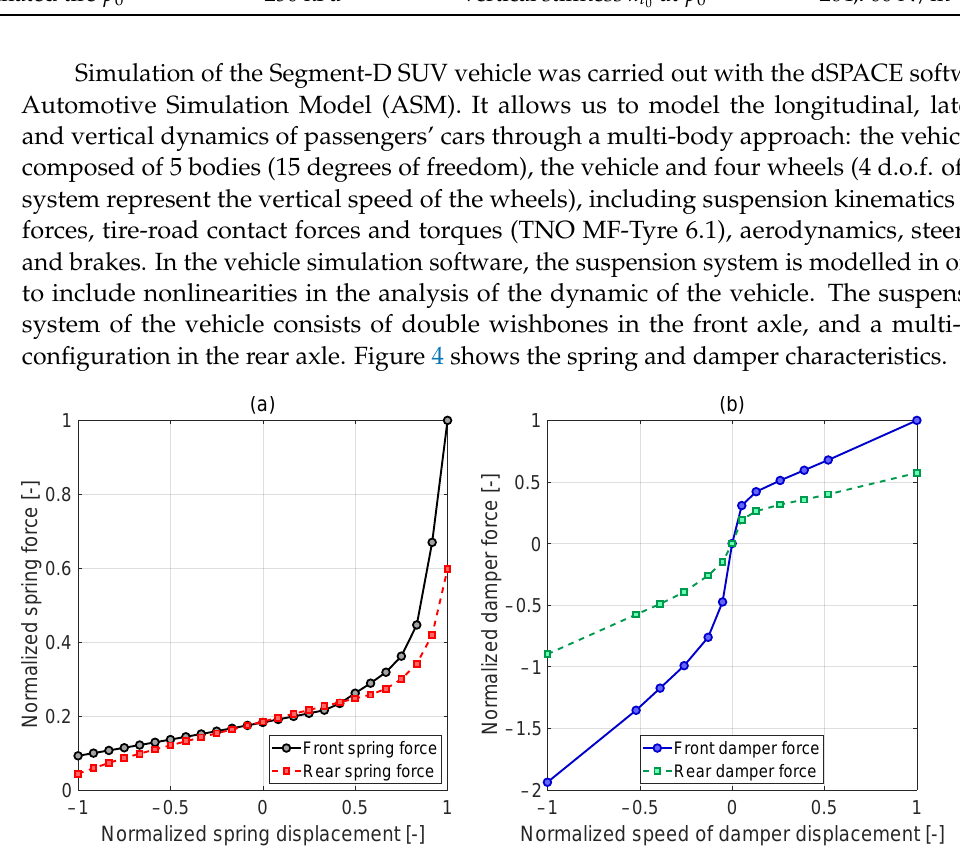
Figure 4. ( a ) Spring force. ( b ) Damper